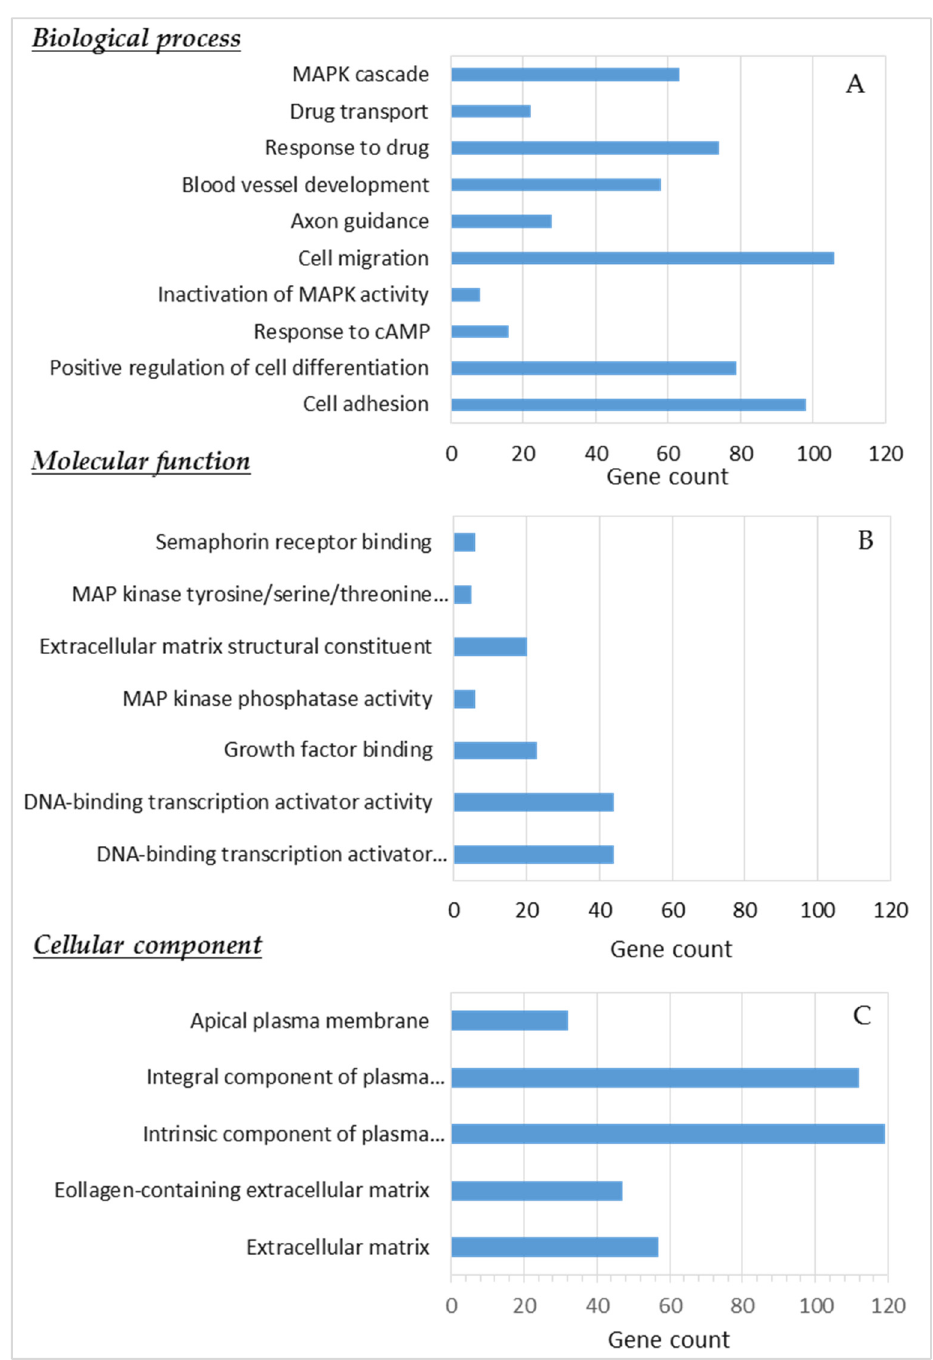
Figure 9. Gene Ontology analysis (( A ) biological processes, ( B ) molecular functions, and ( C ) cellular components) of differentially expressed genes in ENCO+BINI-resistant cell lines. Significant differentially expressed genes with a fold change ≥ 2 and p -value ≤ 0.05 were analysed to determine the enriched Gene Ontology terms.